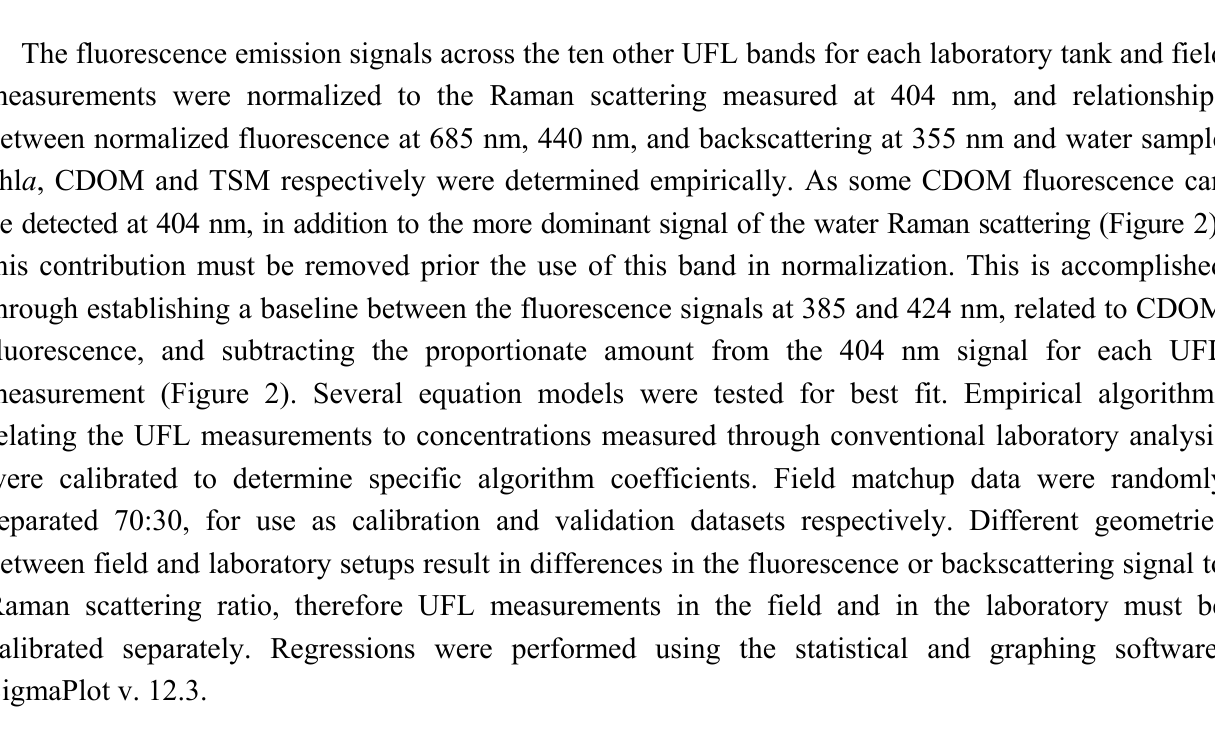
Figure 2. Example fluorescence and backscattering signals measured by UFL (355 nm excitation laser pulse) across its 11 bands, including the removal of the colored dissolved organic matter (CDOM) baseline at 404 nm to establish Raman scattering for